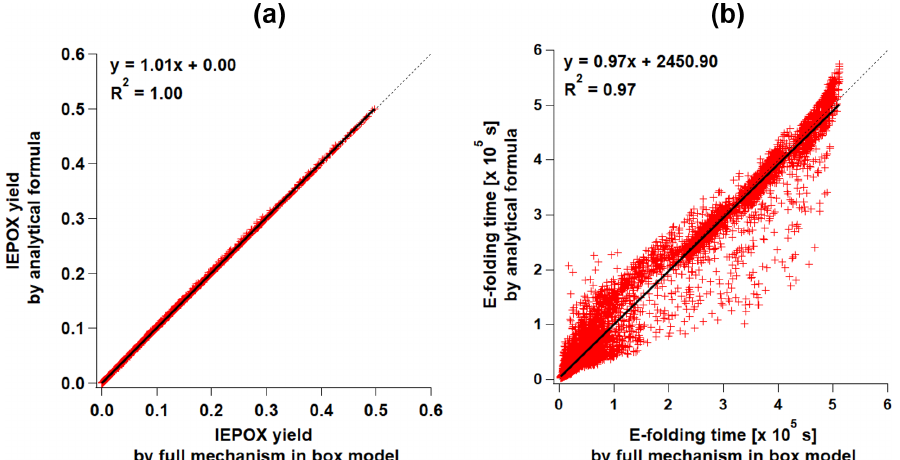
Figure 2. Scatterplots of the results of parameterizations ( y axis) versus the full mechanism ( x axis) box model results for (a) IEPOX molar yield (PAR2 and PAR3) and (b) formation timescale (PAR3). Formation timescale of the full mechanism box model was calculated as follows. We saved IEPOX concentrations for each time step. We defined the formation timescale as the time when the IEPOX concentration is closest to the 1 − 1 /e ( ∼ 63%) of the final IEPOX